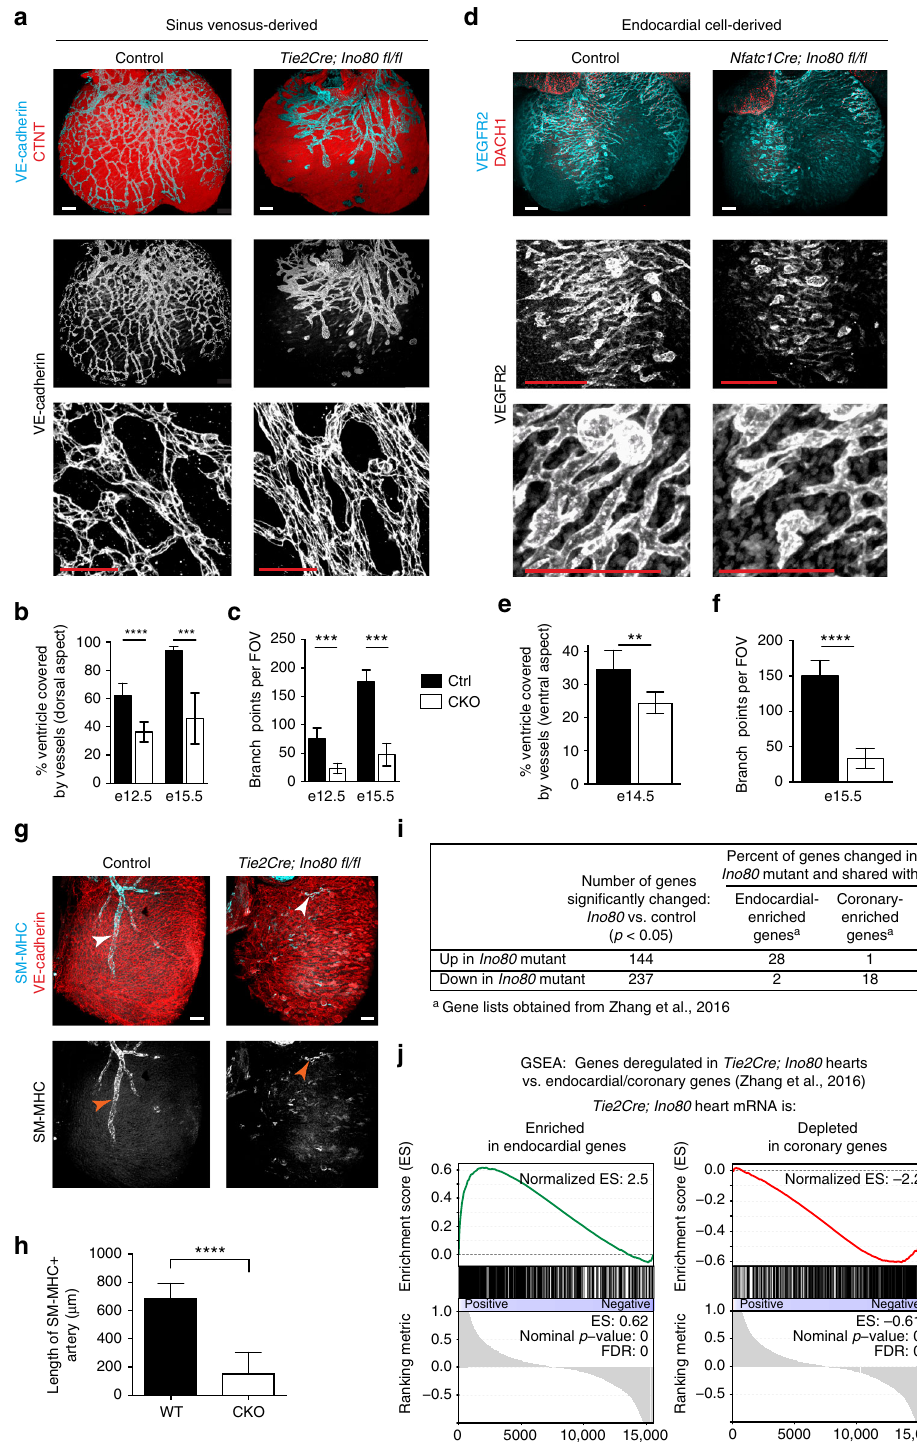
Depleted in coronary genes